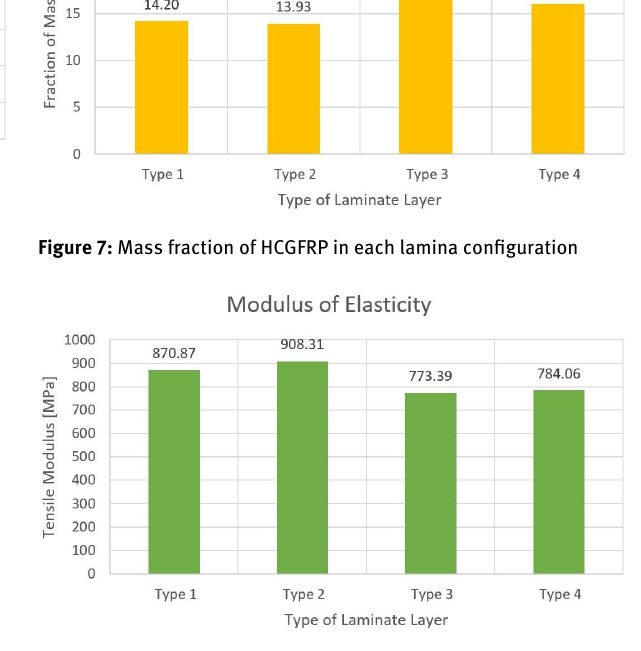
Figure 8: Modulus of elasticity of HCGFRP in each lamina configura-